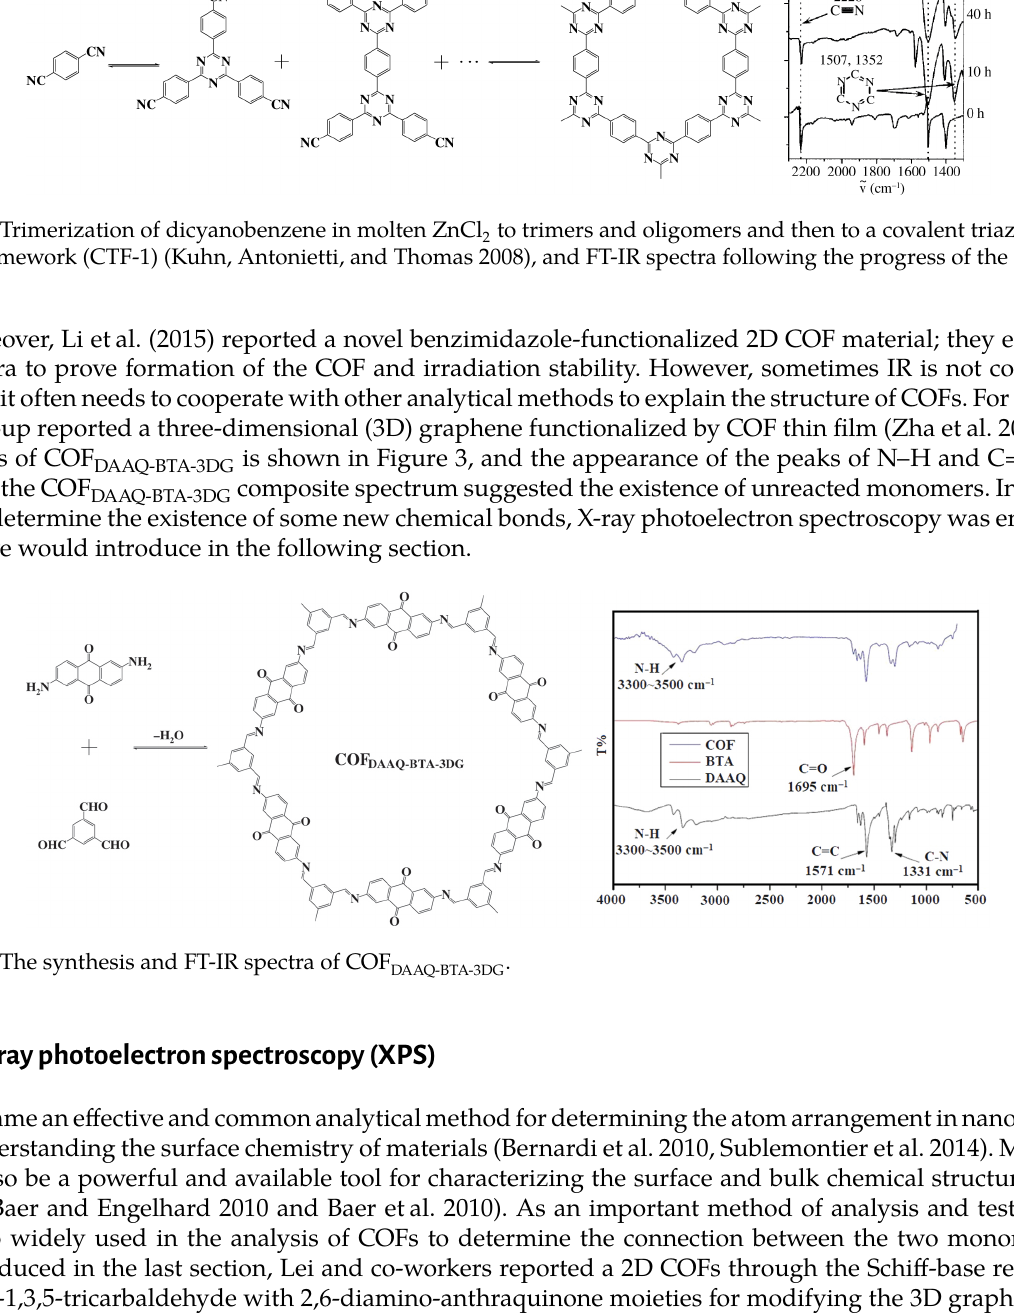
to trimers and oligomers and then to a covalent triazine- 2